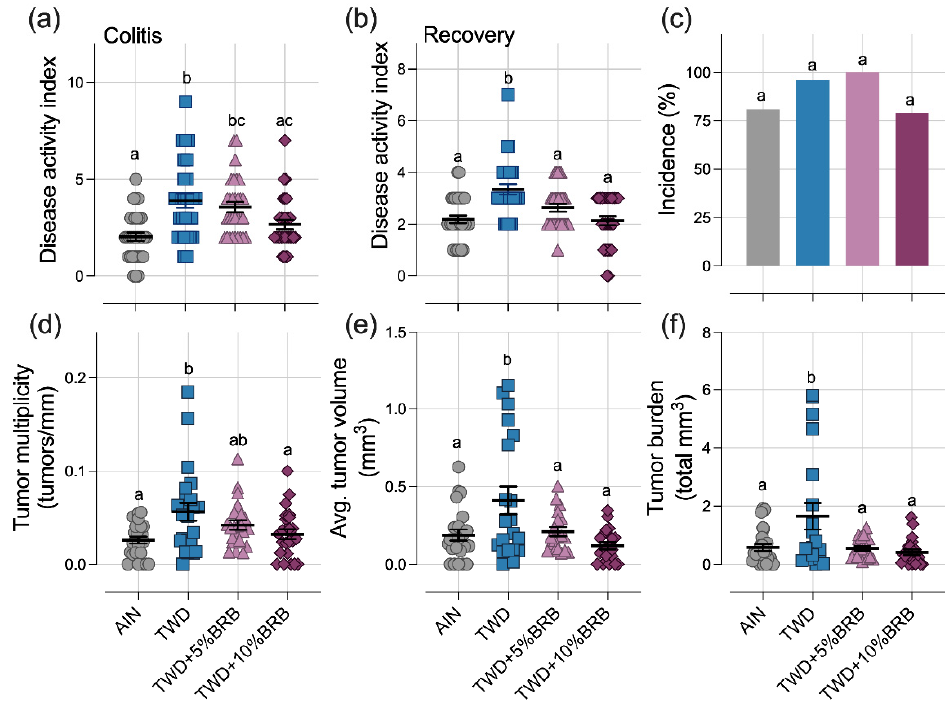
Figure 1. Dietary supplementation with 5 to 10% BRB suppressed symptoms of colitis and colon tumorigenesis in mice fed TWD (experiment A). ( a , b ) Disease activity index (DAI) score during active colitis on day 33 ( a ) and recovery from gut injury on day 45 ( b ). ( c ) Incidence of colon tumors shown as the percent of mice with tumors. ( d ) Colon tumor multiplicity (number of tumors per mm colon length). ( e ) Average tumor volume. ( f ) Tumor burden (total volume). For ( a , b ) and ( d – f ), data are shown as individual values with mean ± SE. Different letters indicate that treatment groups are significantly different ( p < 0.05), as determined by statistical methods outlined in the Materials and Methods section.